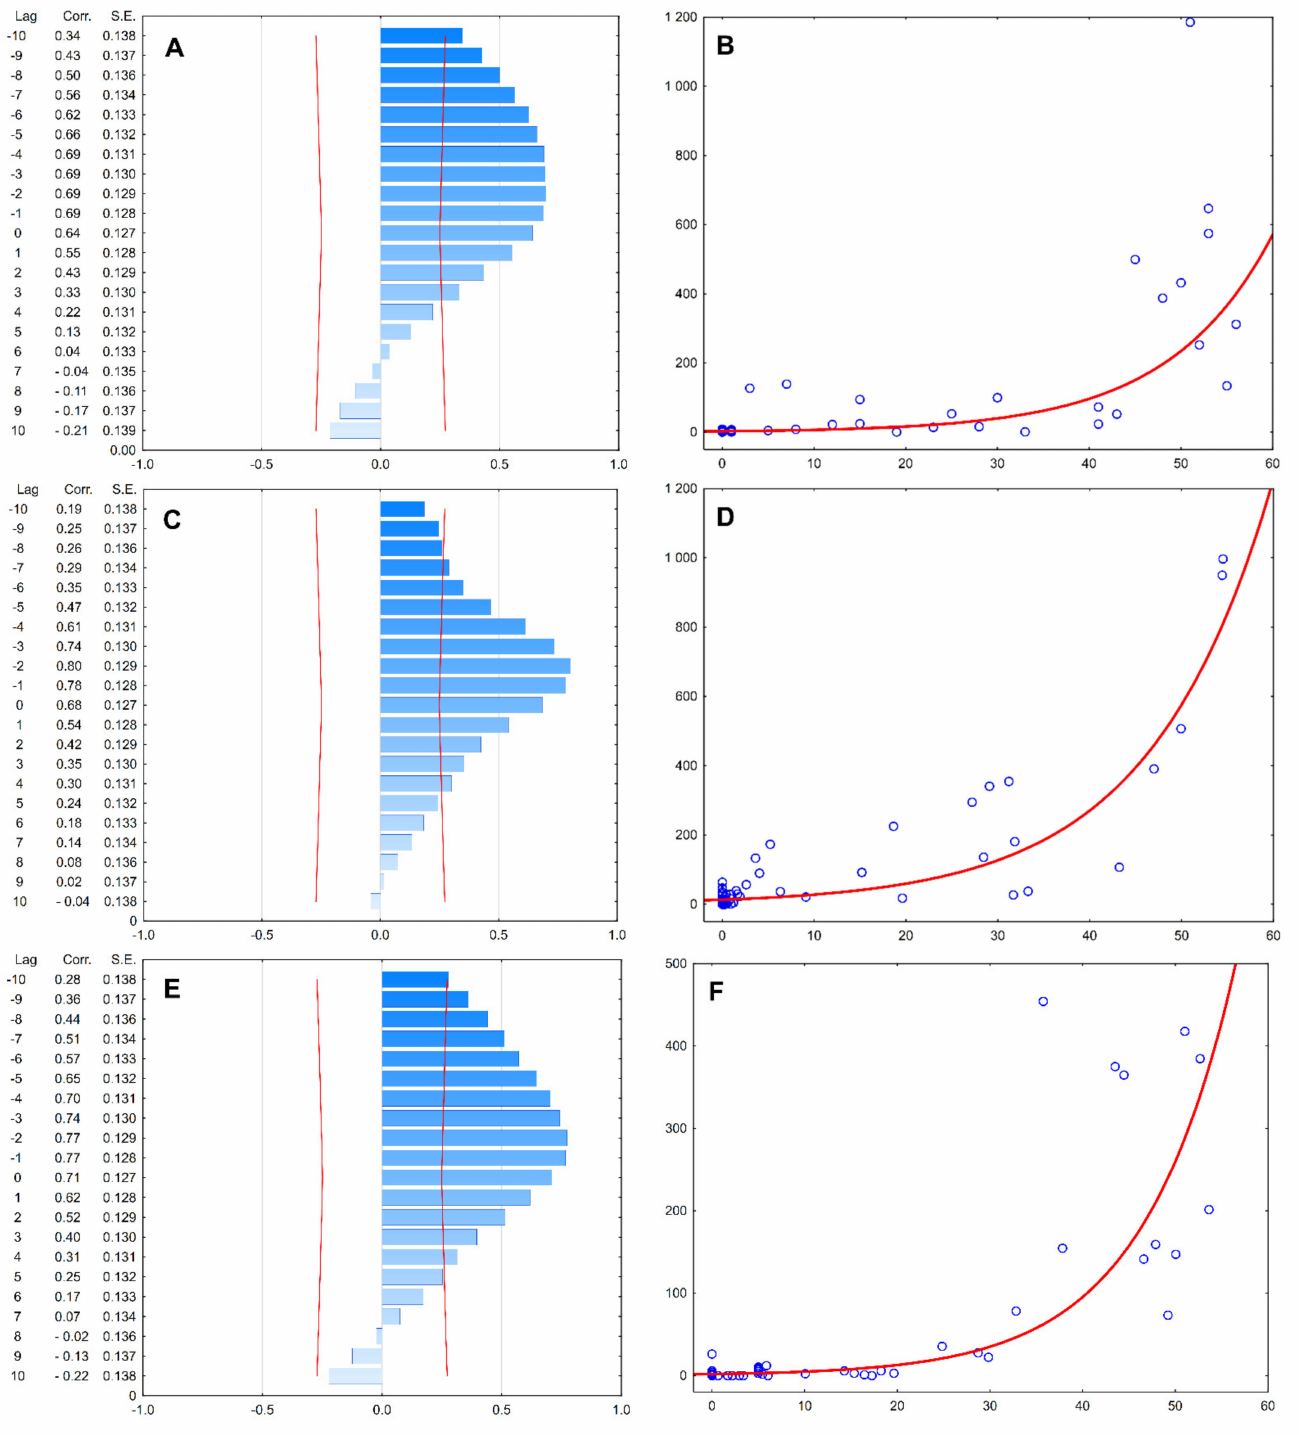
Figure 6. Relationships between pollen season (dependent variable) and flowering season (lagged variable) in Augsburg, during 2015–2017 (time-series analysis, cross-correlations): ( A , B ): 2015, ( C , D ): 2016, ( E , F ): 2017. The left panel shows the cross-correlations for a range of − 10 to +10 lags (red line marks the confidence interval at p = 0.05). The right panel shows the relationship (simple regression with exponential fit, at the strongest correlation lag for all years ( − 2)) between the pollen concentration of Betula